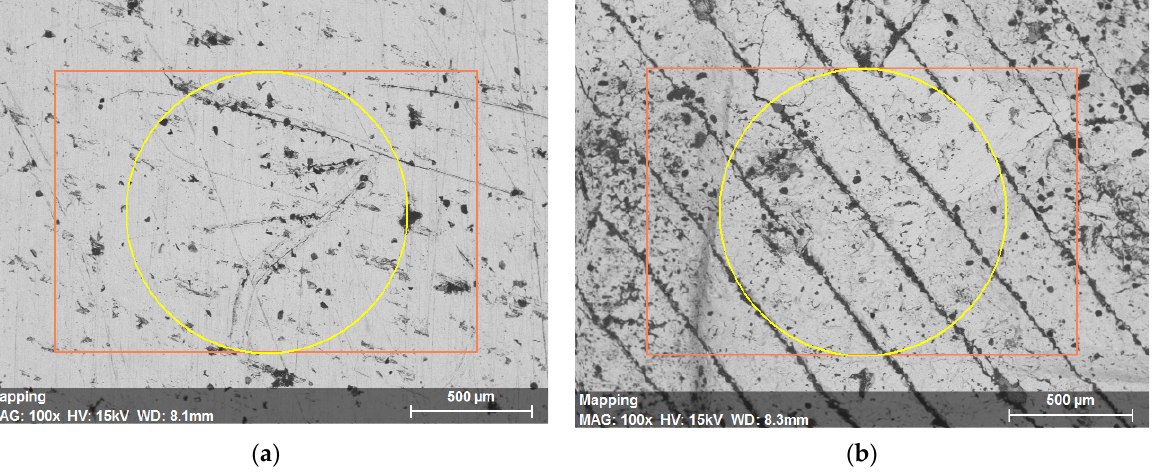
Figure 9. SEM images ×100: ( a ) Electrolytic part; (b) ADAM part. The colored graphs correspond to the areas bounded by the EDX software for the realization of the analyses.